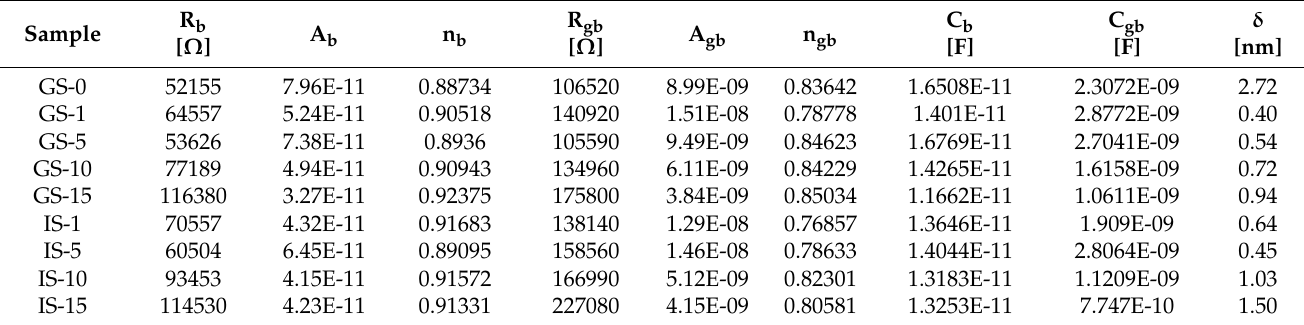
Table 7. Grain boundary thickness ( δ ) in the investigated sinters, as calculated using Equations (12)– (15) as well as a number of physical parameter (R b , A b , n b , R gb , A gb , n gb , C b and C gb ) corresponding to equivalent circuit elements.